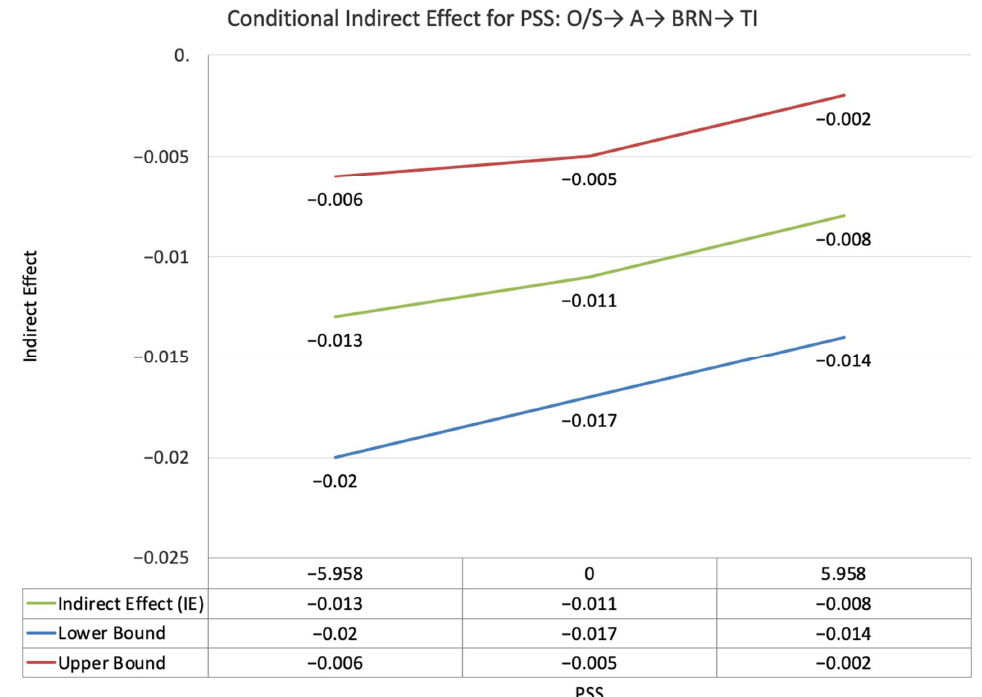
Figure 10. Conditional indirect effects of the difference between self-PMIEs compared to other-PMIEs on turnover intentions at low, average and high levels of perceived supervisor support, through autonomy satisfaction and burnout.